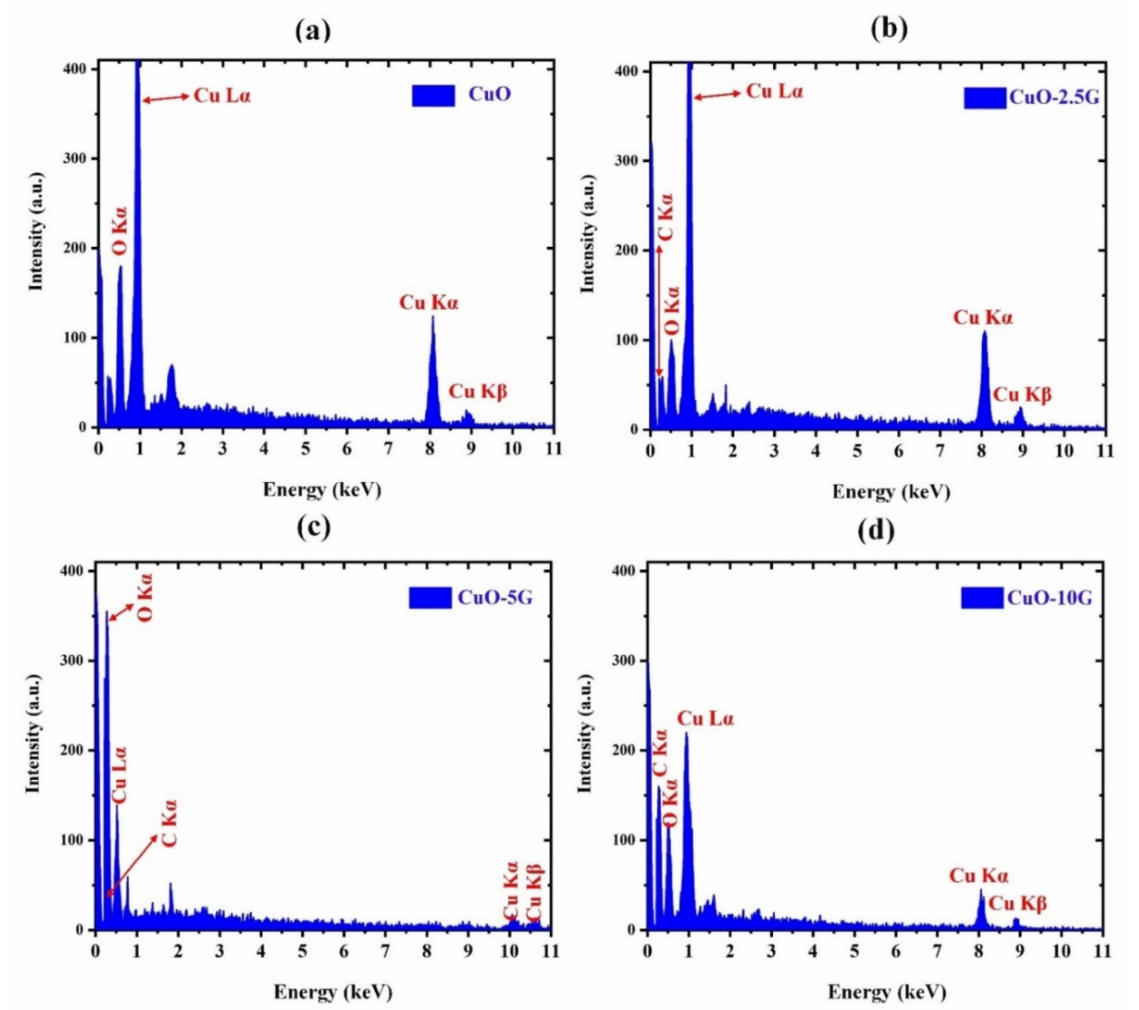
Figure 4. EDX spectra of the samples: ( a ) CuO, ( b ) CuO-2.5G, ( c ) CuO-5G and ( d ) CuO-10G.